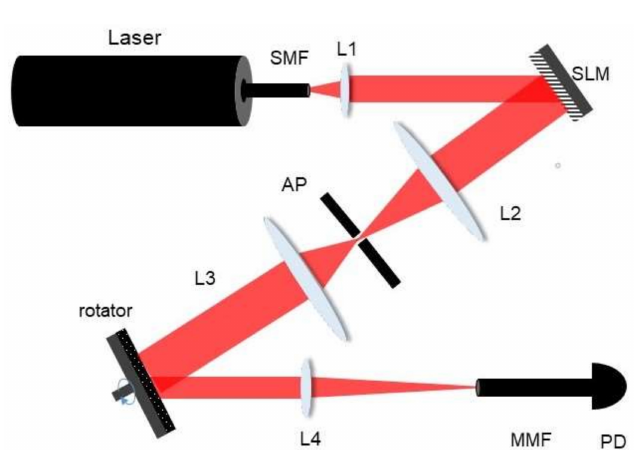
Figure 8. Experimental setup to measure the frequency shift of scattered light from a rotating rough surface, based on RDE. L1~4: Lens, SMF: Single mode fiber, SLM: Spatial light modulator, AP: Aperture, MMF: Multimode fiber, PD: